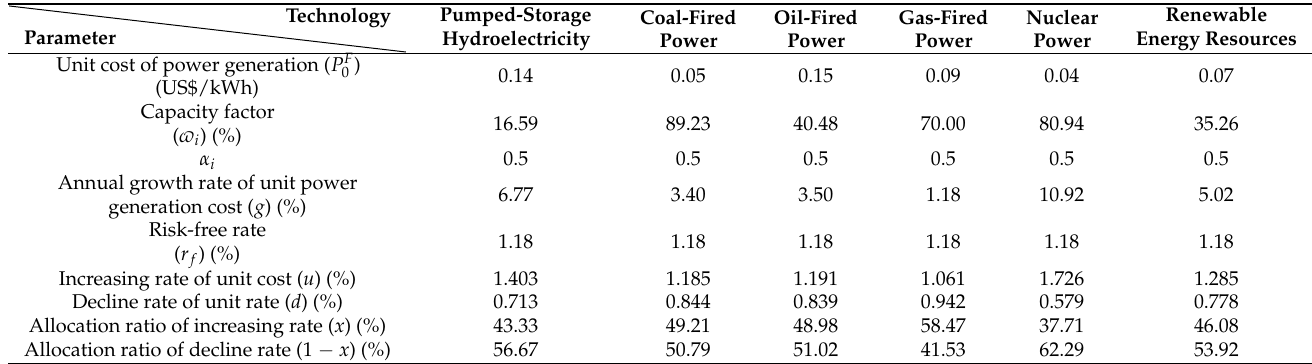
Table 1. Parameters value of various power generation